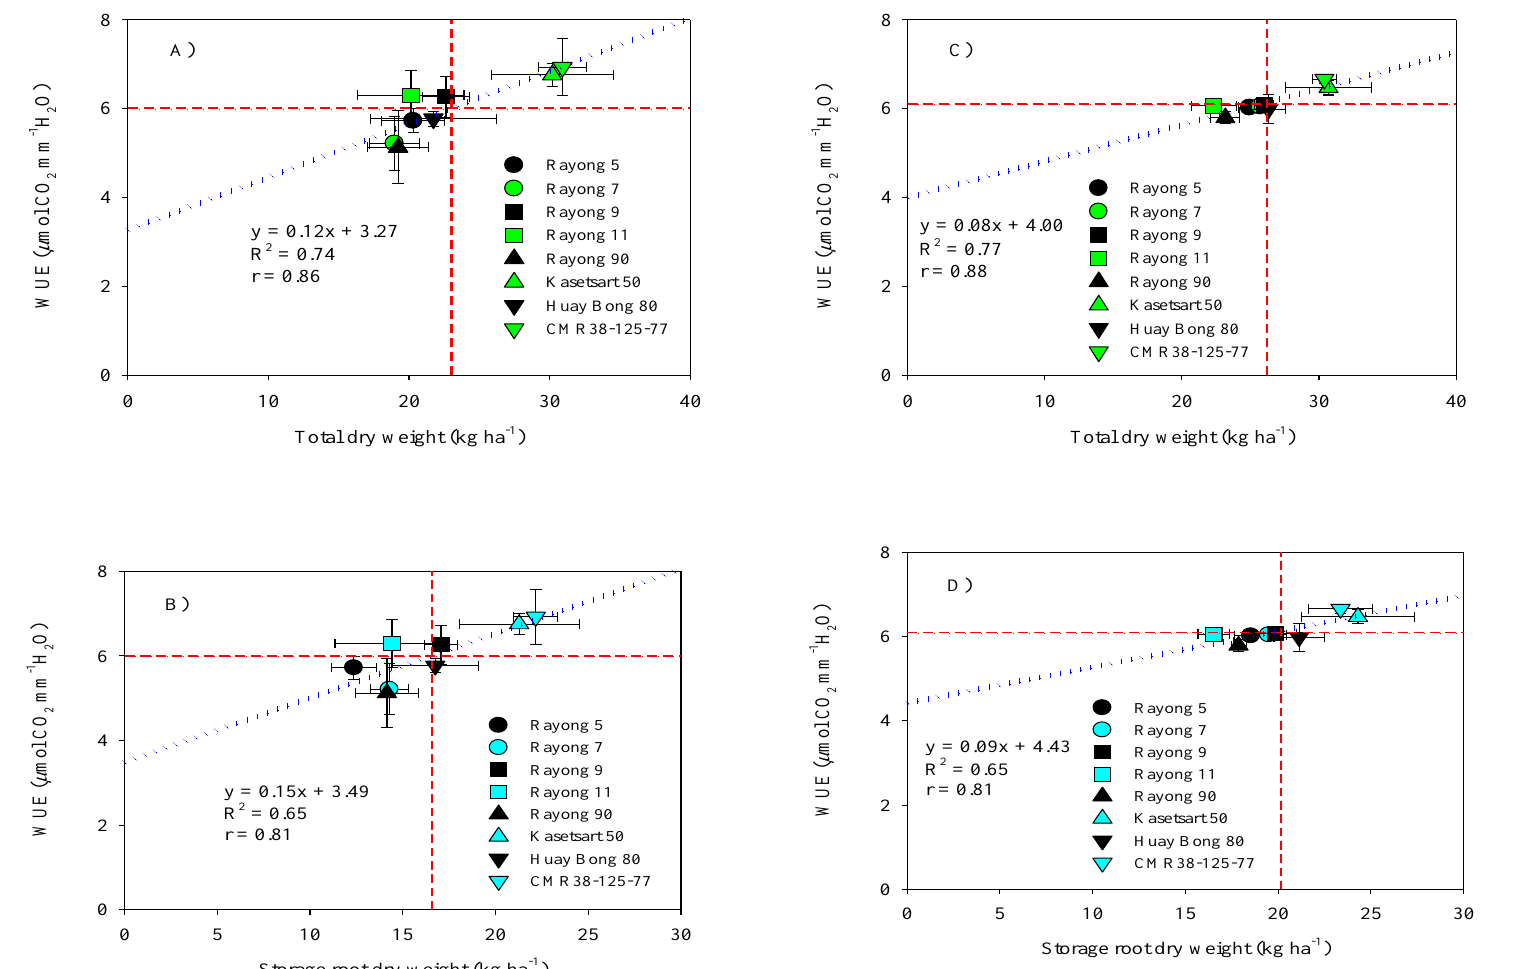
Figure 4. The relationship between biomass and water use efficiency (WUE) for eight different cassava genotypes at 2018/2019 ( A , B ) and at 2019/2020 ( C , D ). The dash lines represent means for biomass and WUE.